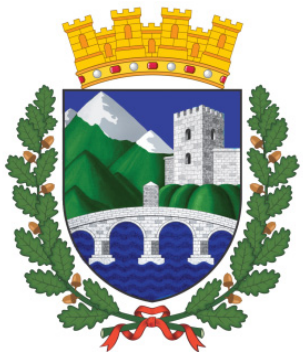
Figure 18. The arms of Skopje, unofficial (A. Kurov, J. Jonovski). The diadems of the historic capitals of Ohrid and Prilep are officially distinguished by a row of rubies alternating with pearls (Figure 19) (Jo н o в c ки 2015). The rural crown represents a palisade crown made up of a series of seven visable pales placed on a golden diadem (Figure 20).